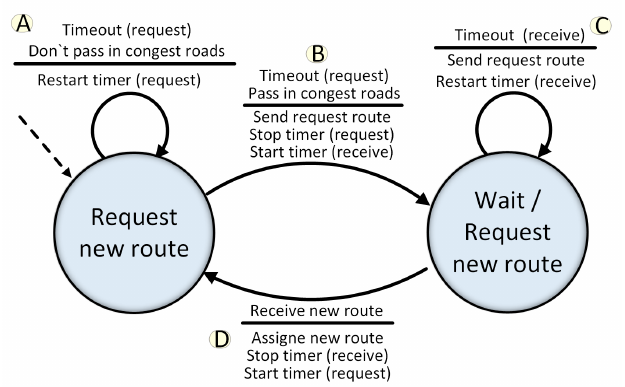
Figure 6. State diagram: Request new route.